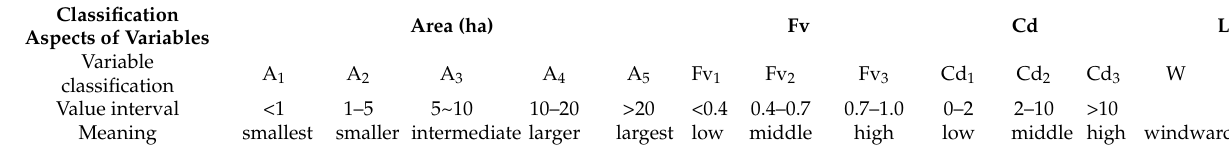
Table 2. Value interval and meaning of subcategories of green space morphological factors.